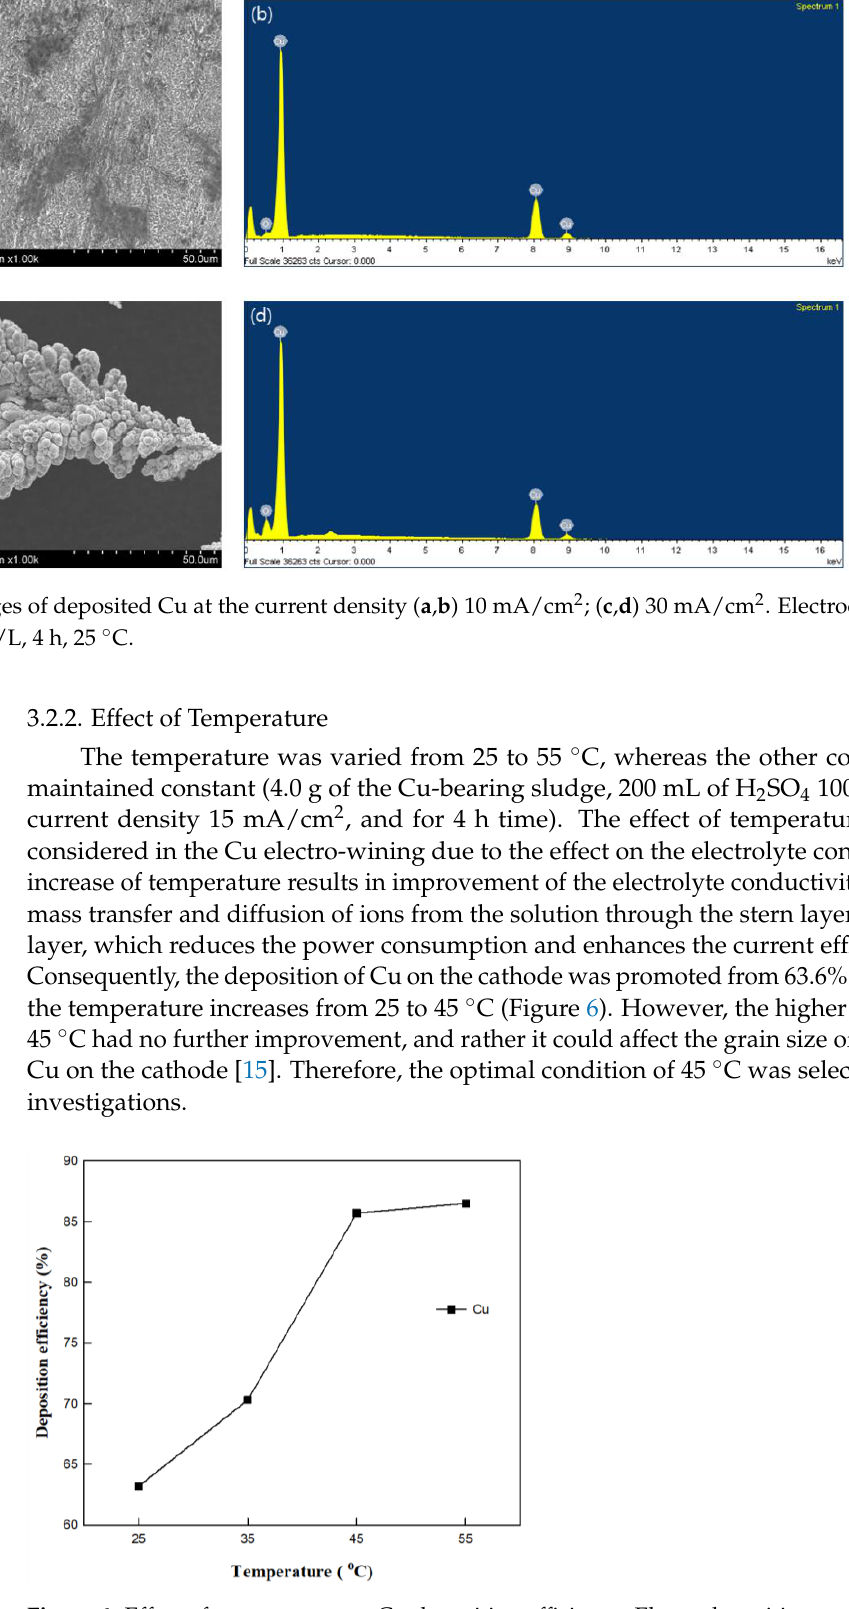
Figure 6. Effect of temperature on Cu deposition efficiency. Electrodeposition conditions: H 2 SO 4 100 g/L, current density 15 mA/cm 2 , 4 h, 25–55 °C.